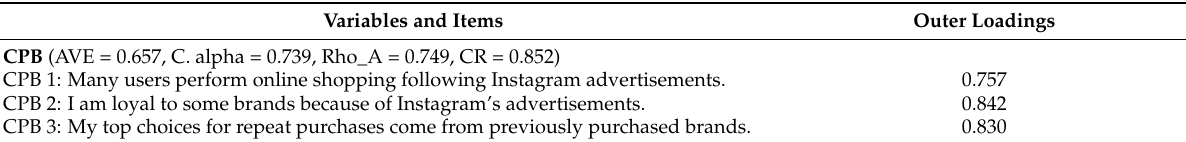
Table 2. Measurement models, convergent validity, and